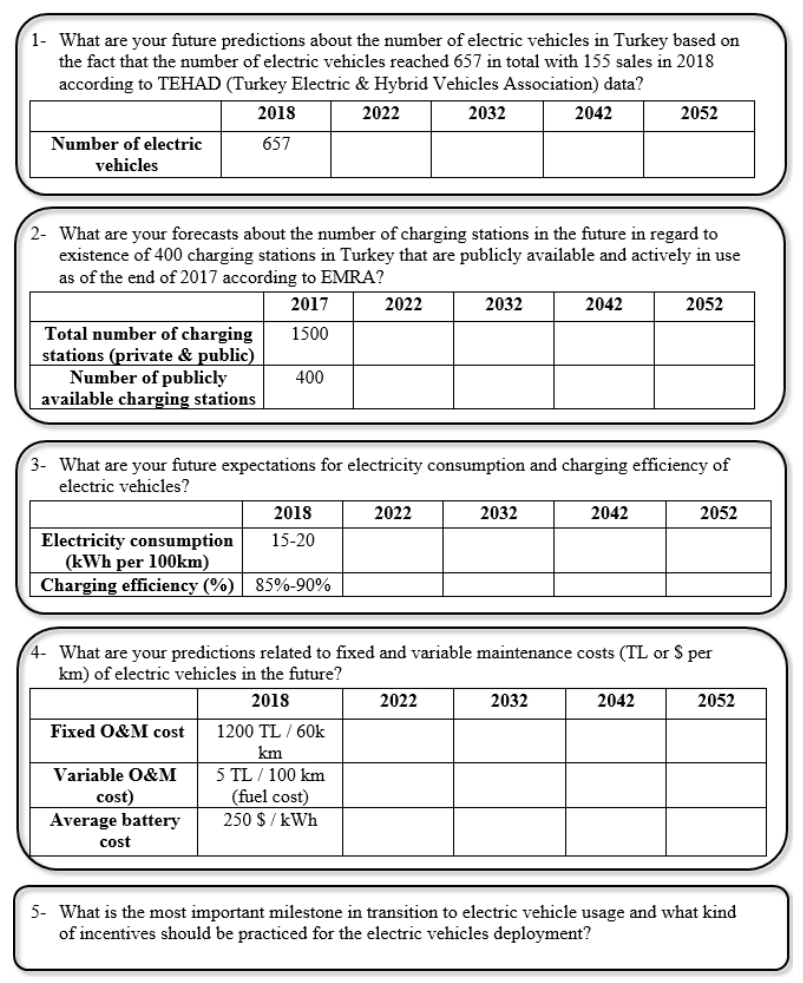
Figure A1. Electric vehicle deployment projection survey in